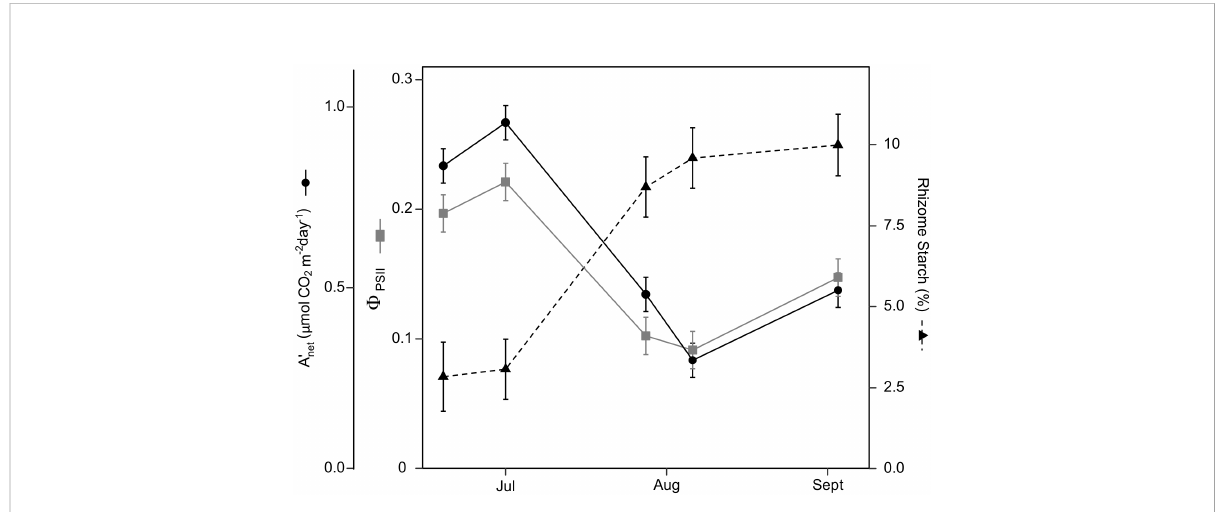
Switchgrass daily net CO 2 assimilation ( A 0 net ), ef fi ciency of photosystem II ( PSII ), and rhizome starch content during 2020. As the season progressed A 0 net and PSII decreased by ~50%, while rhizome starch increased 4-fold. During the fi rst two sampling dates, switchgrass was in vegetative stages, the next two was in reproductive stages and in the last measurement switchgrass was 70% senesced. Error bars represent plus/minus one standard error of the mean (n =